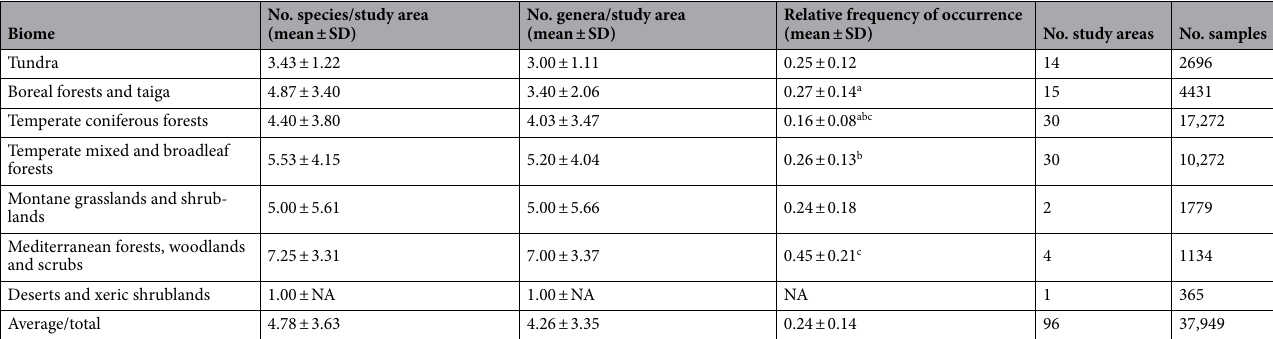
Table 1. Average values (mean ± SD) among study areas of the number of taxa (species and genera) and relative frequency of occurrence (number of occurrences of fleshy-fruited plant species divided by the total number of occurrences of all food items consumed) of fleshy fruits eaten by brown bears in each biome within brown bear distribution range and in the entire range. The total number of studies and samples examined is also indicated for each biome. The same letter (a, b, c) after the scores of the relative frequency of occurrence in different biomes indicate statistical differences between these biomes (e.g. letter “a” represents statistical differences in the frequency of occurrence of fleshy fruits in brown bears diet between boreal forests and taiga and temperate coniferous